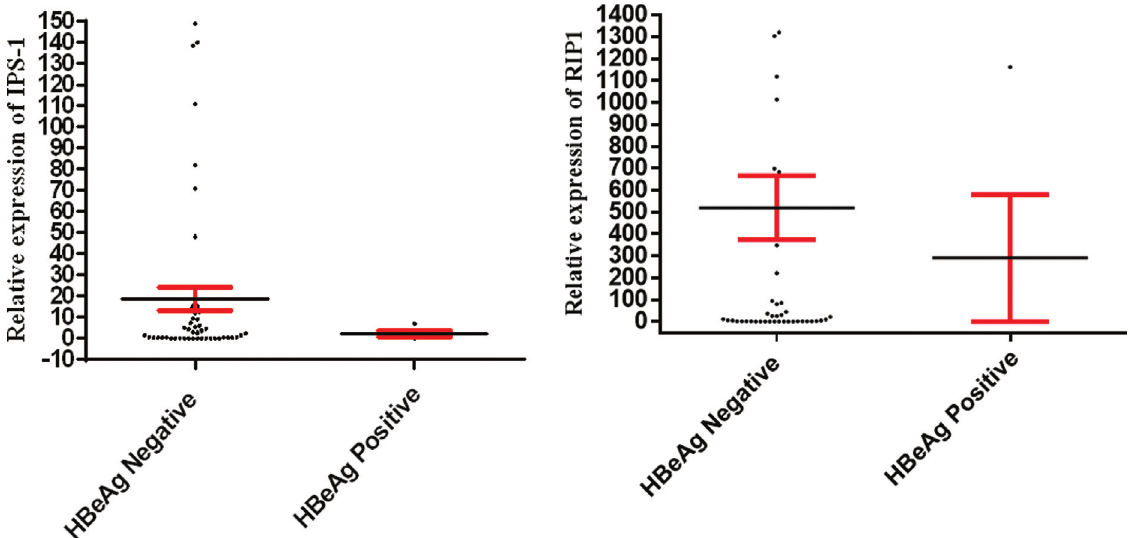
Figure 3 - IPS-1 and RIP1 gene expression in HbeAg-positive and negative patients with chronic hepatitis B. The figure shows that HBeAg positive and negative patients did not show differences in their IPS-1 and RIP1 mRNA levels. Data are presented as mean (cid:4) standard errors. The results regarding the expression levels of IPS-1 and RIP1 are reported as fold-changes (Ebrahim et al. , 2015).